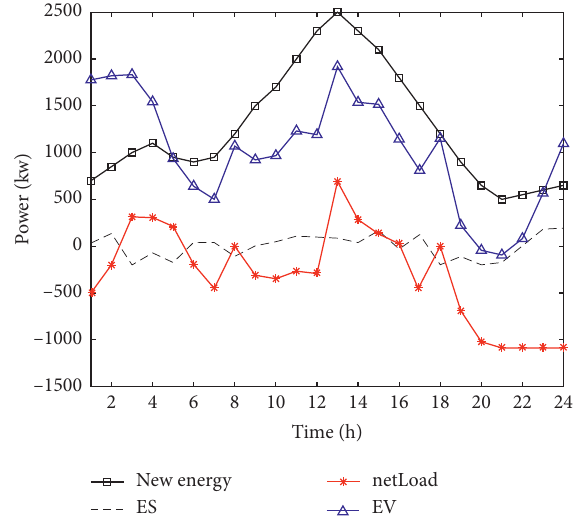
Figure 8: Power output of each unit at the source-load level.